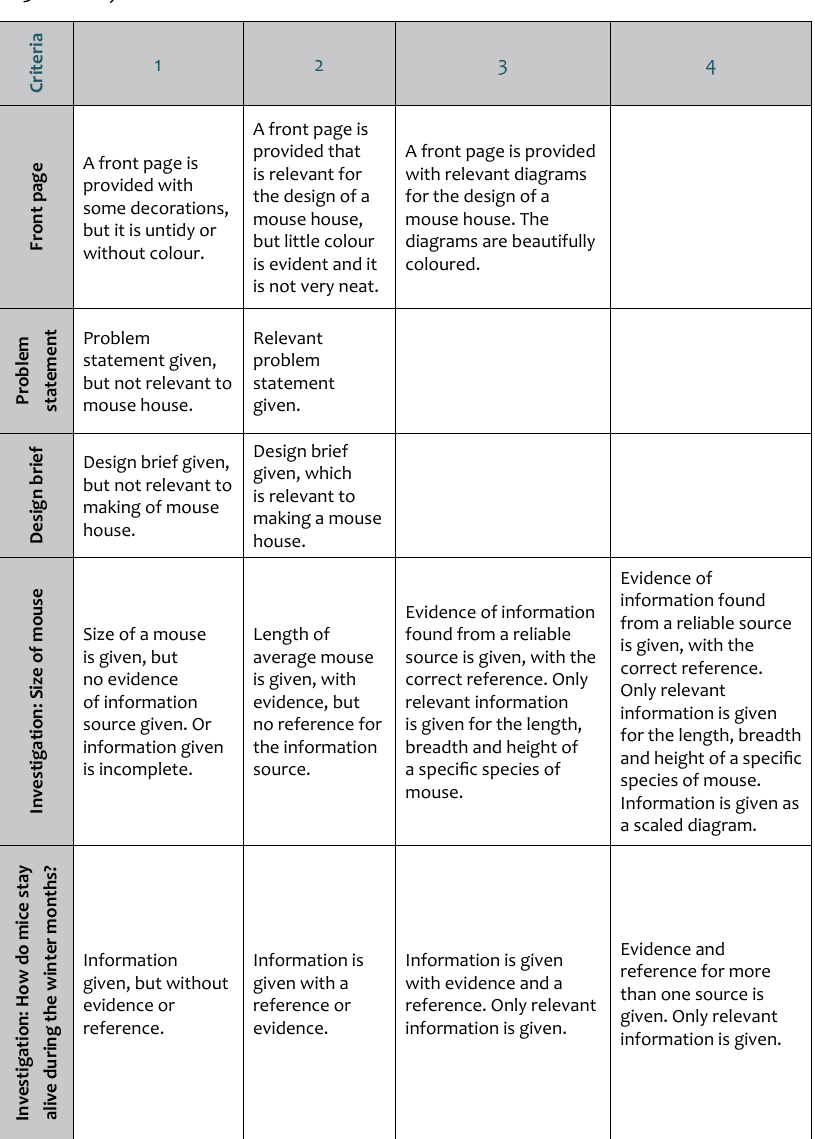
A front page is provided with some decorations, but it is untidy or without colour.